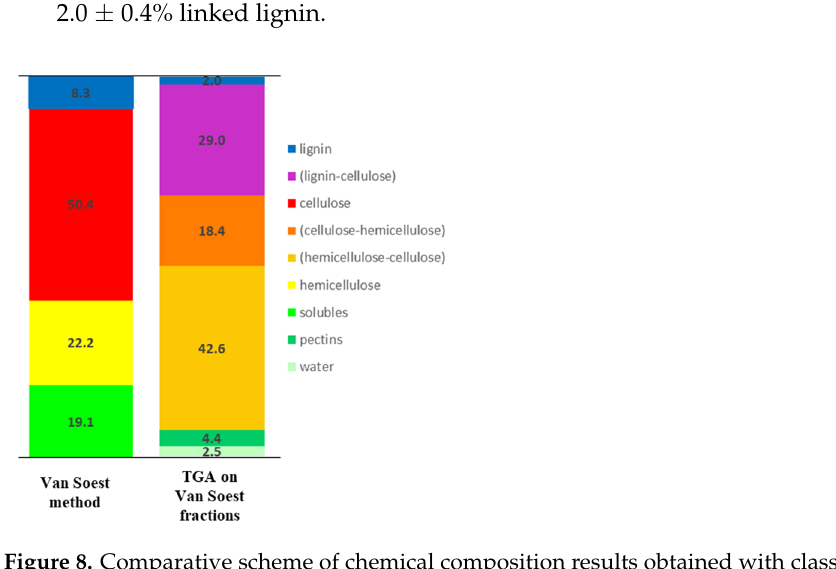
Figure 8. Comparative scheme of chemical composition results obtained with classic method Van Soest and the investigated method.